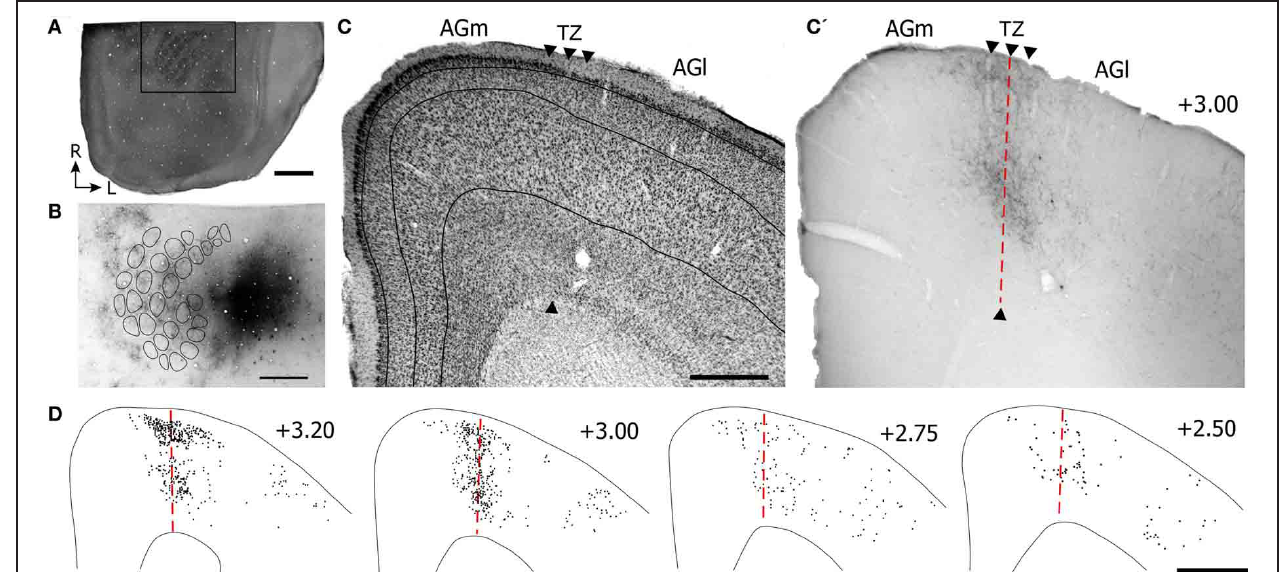
FIGURE 4 | ProjectionsfromSII cortexterminatein thetransitionalregion betweenAGmandAGl.(A) Tangential section depicting theCO-labeled barrel field inSI. Rectangle indicates the area depicted in panel (B) . (B) Multiple